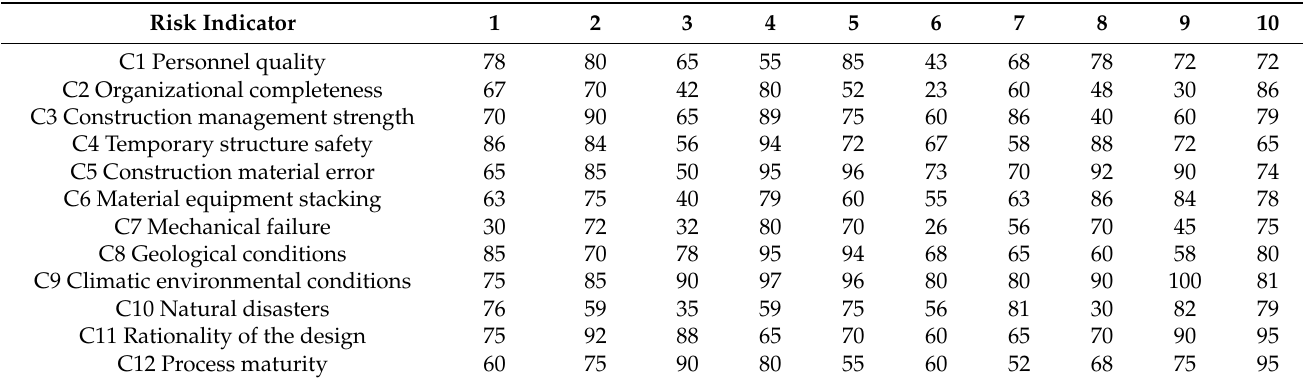
Table 2. Risk indicator scoring